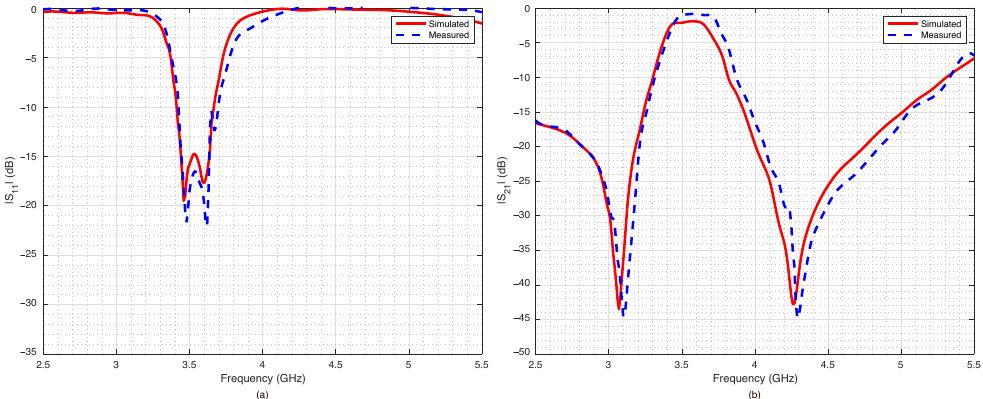
Figure 17. Simulated vs. measured scattering parameters of the pseudohairpin filter prototype: ( a ) return loss S 11 , ( b ) insertion loss S 21 . RF-MEMS switches configuration 111 (all on).